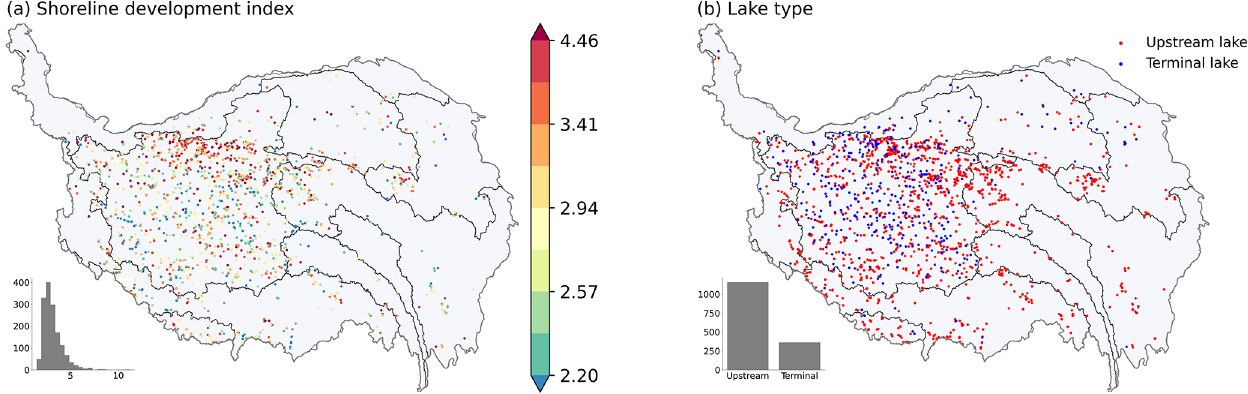
Figure 6. Spatial distribution of shoreline development index (a) and type (b) on the